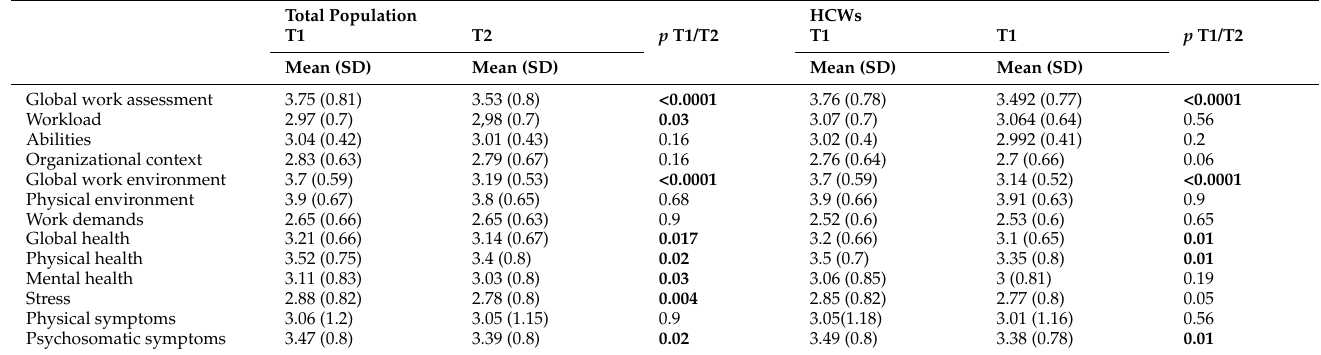
Table 4. Trends of work stressors’ impacts and psychosocial factor